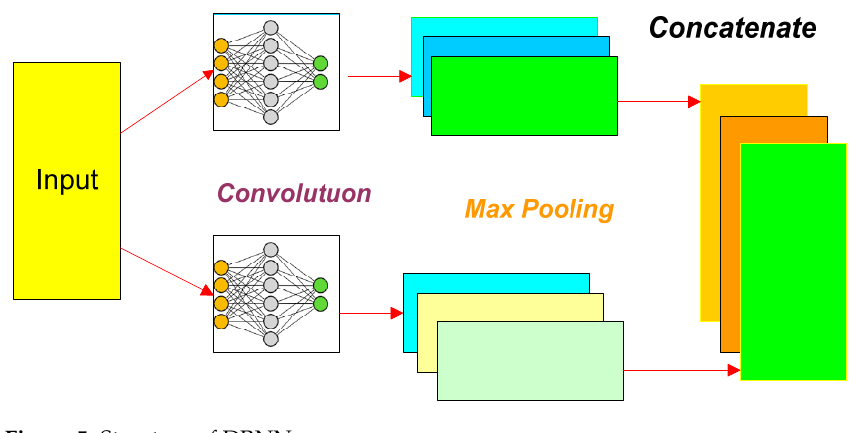
Figure 5 . Structure of DRNN . Figure 5. Structure of